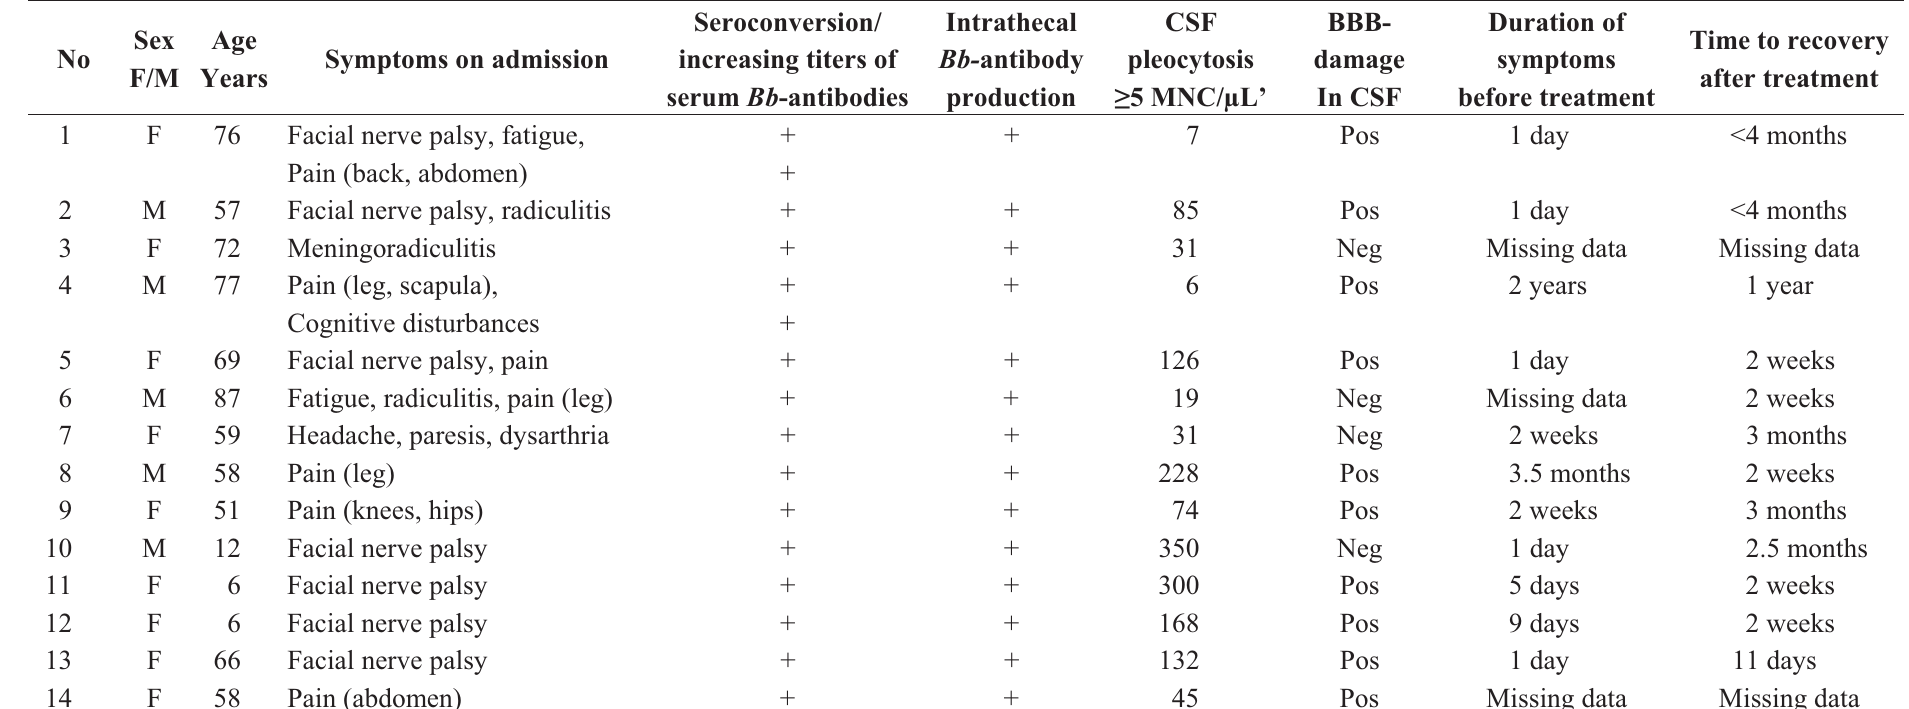
Table 4. Patient characteristics and clinical findings in patients with Lyme neuroborreliosis (n =